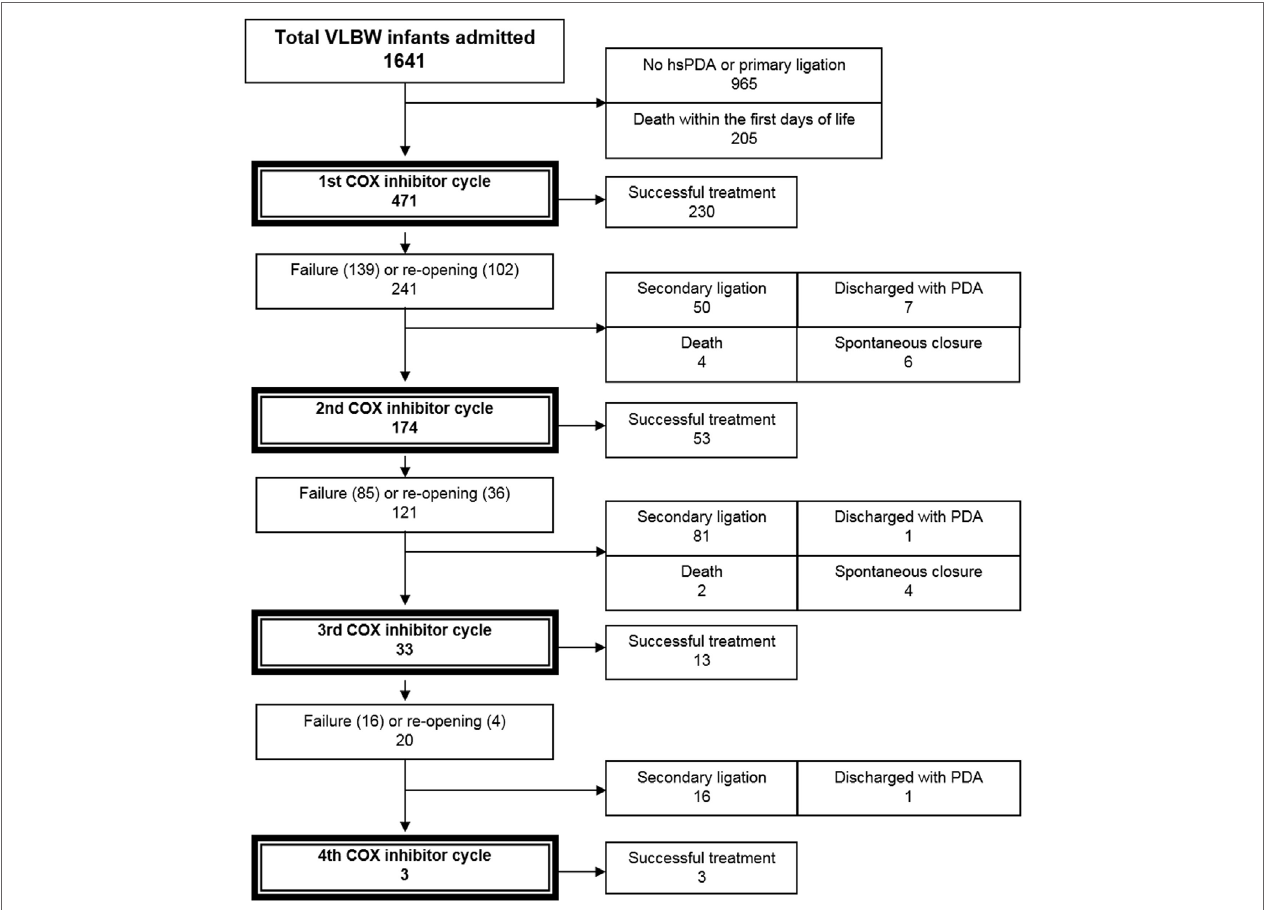
FigUre 1 | Flowchart: study population. Treatment with COX inhibitors was considered successful, if no further PDA therapy was required. COX, cyclooxygenase; hsPDA, hemodynamically significant PDA; PDA, patent ductus arteriosus; VLBW, very low birth weight ( < 1,500 g).